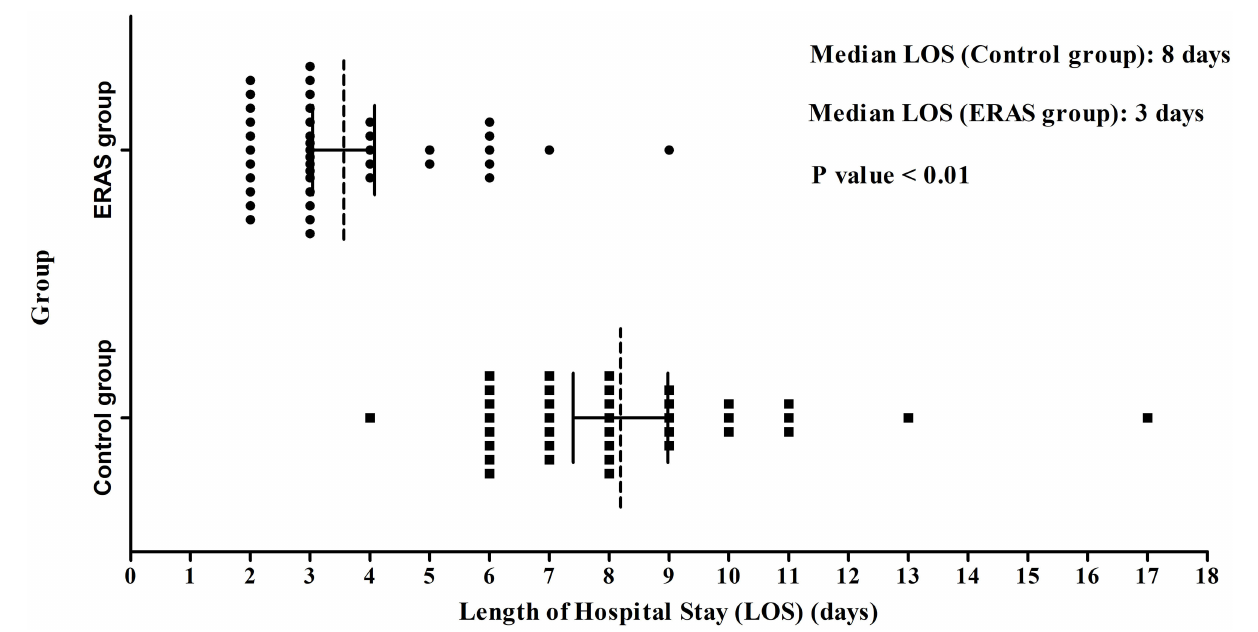
FIGURE 1 | LOS in the ERAS and Control groups. The median LOS of the ERAS group (3 days) was shorter than that of the control group (8 days) ( P < 0.01). LOS, length of stay after operation.